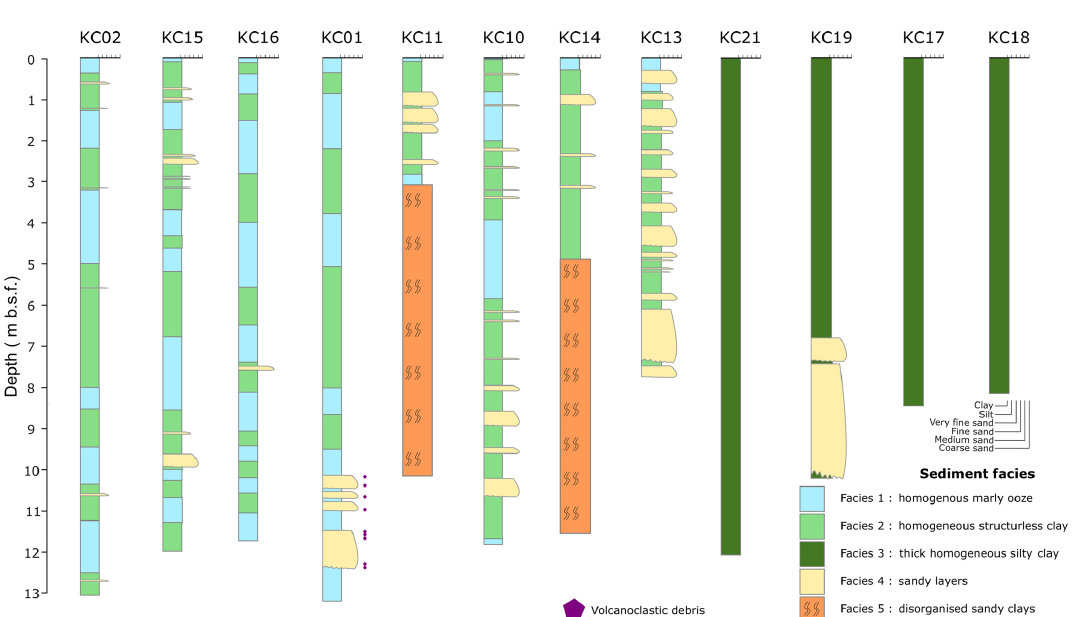
Figure 5. Sedimentological core logs from the Ogooue Fan, showing grain size variation, lithology and bed thickness (locations of cores are presented in Fig.